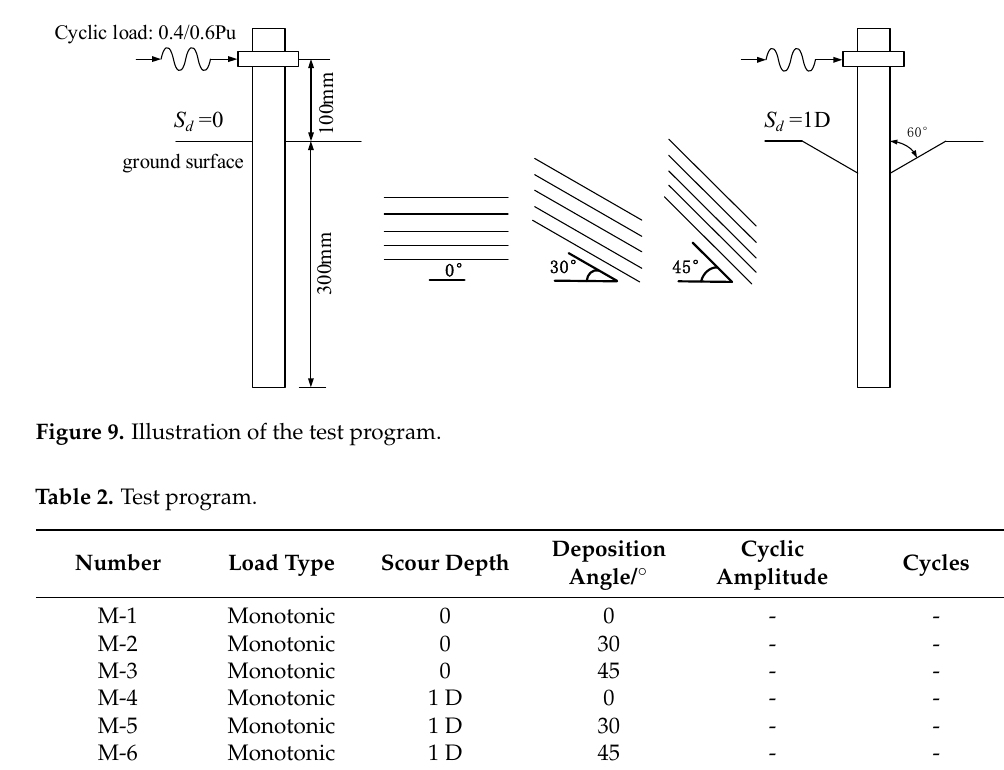
Figure 8. Different cyclic loading types [28].